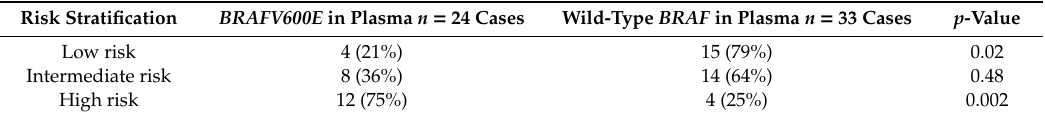
Table 2. Risk stratification of the patients with BRAFV600 -positive papillary thyroid